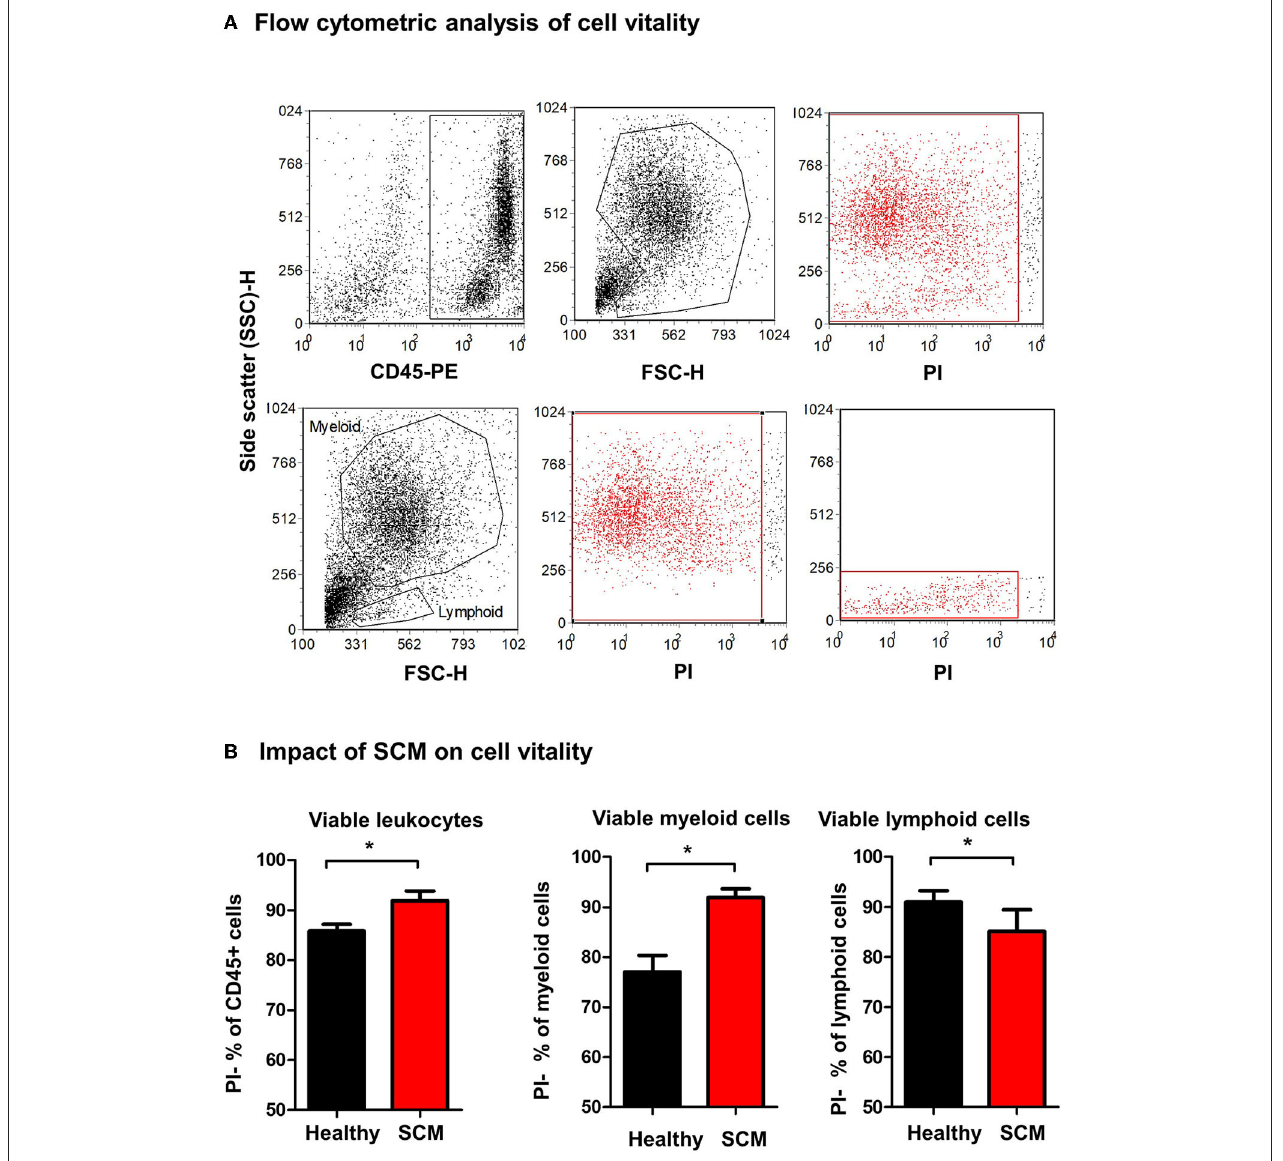
FIGURE 4 | Separated milk cells were labeled with CD45 antibodies and labeled cells were loaded with the nucleic acid stain propidium iodide and analyzed by flow cytometry. (A) After gating on leukocytes (CD45 + cells) and the exclusion of cell debris in a SSC-H against FSC-H dot plot, milk phagocytes and lymphocytes were gated based on their FSC and SSC properties. (B) The percentage of viable PI-negative cells were calculated in a SSC-H against FL-3 dot plot and the values were presented for total leukocytes, myeloid cells, and lymphoid cells, and presented graphically. *indicates significant differences between the means with p -values <